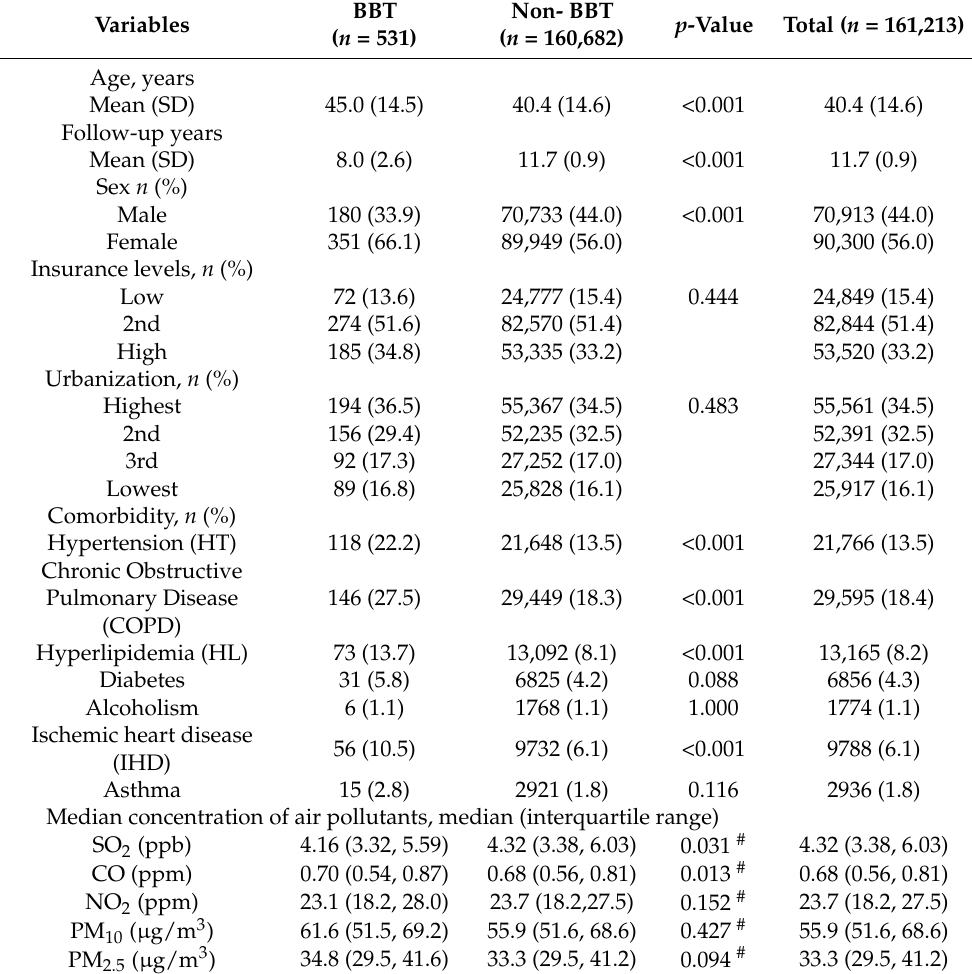
Table 1. Distribution of the demographic data, comorbidities, and air pollutants of the study participants. Variables